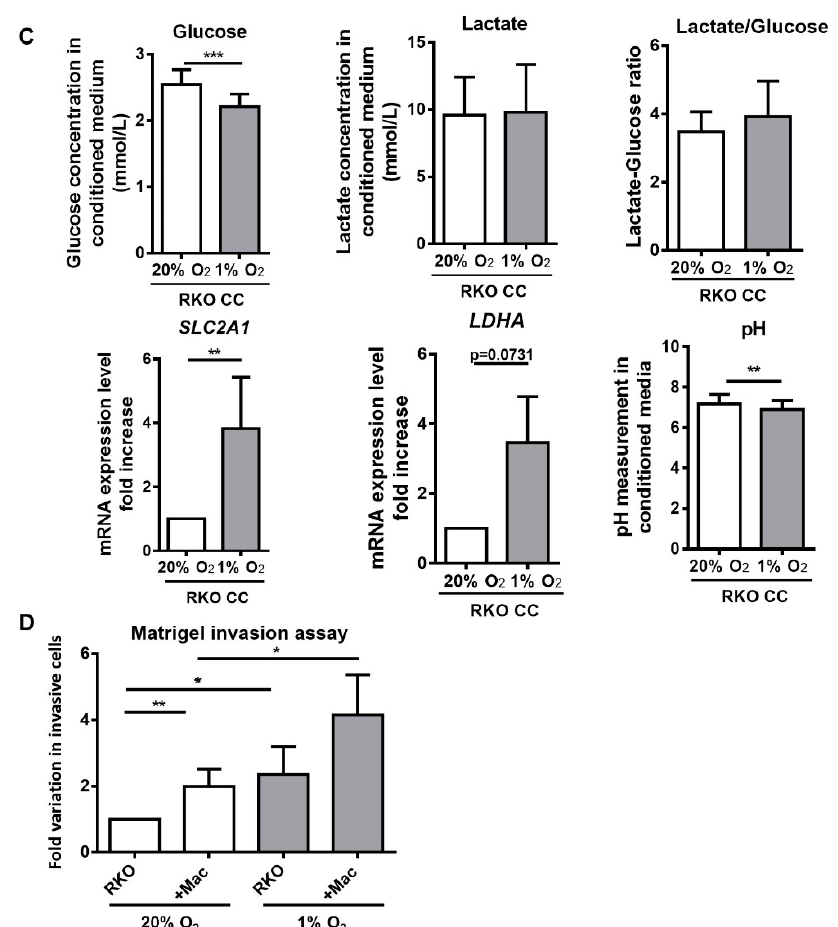
Figure 5. Hypoxia impacts colon cancer cell behavior, increasing invasion and glucose consumption.